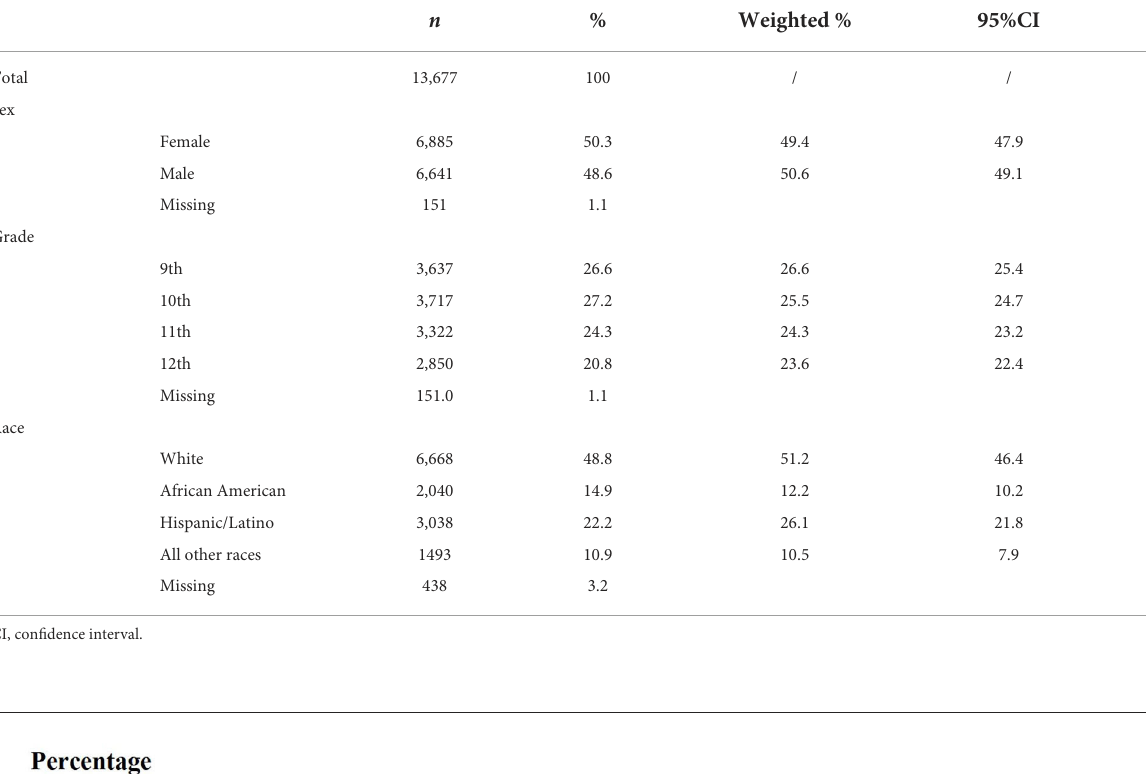
TABLE 1 Demographic characteristics of the participants.